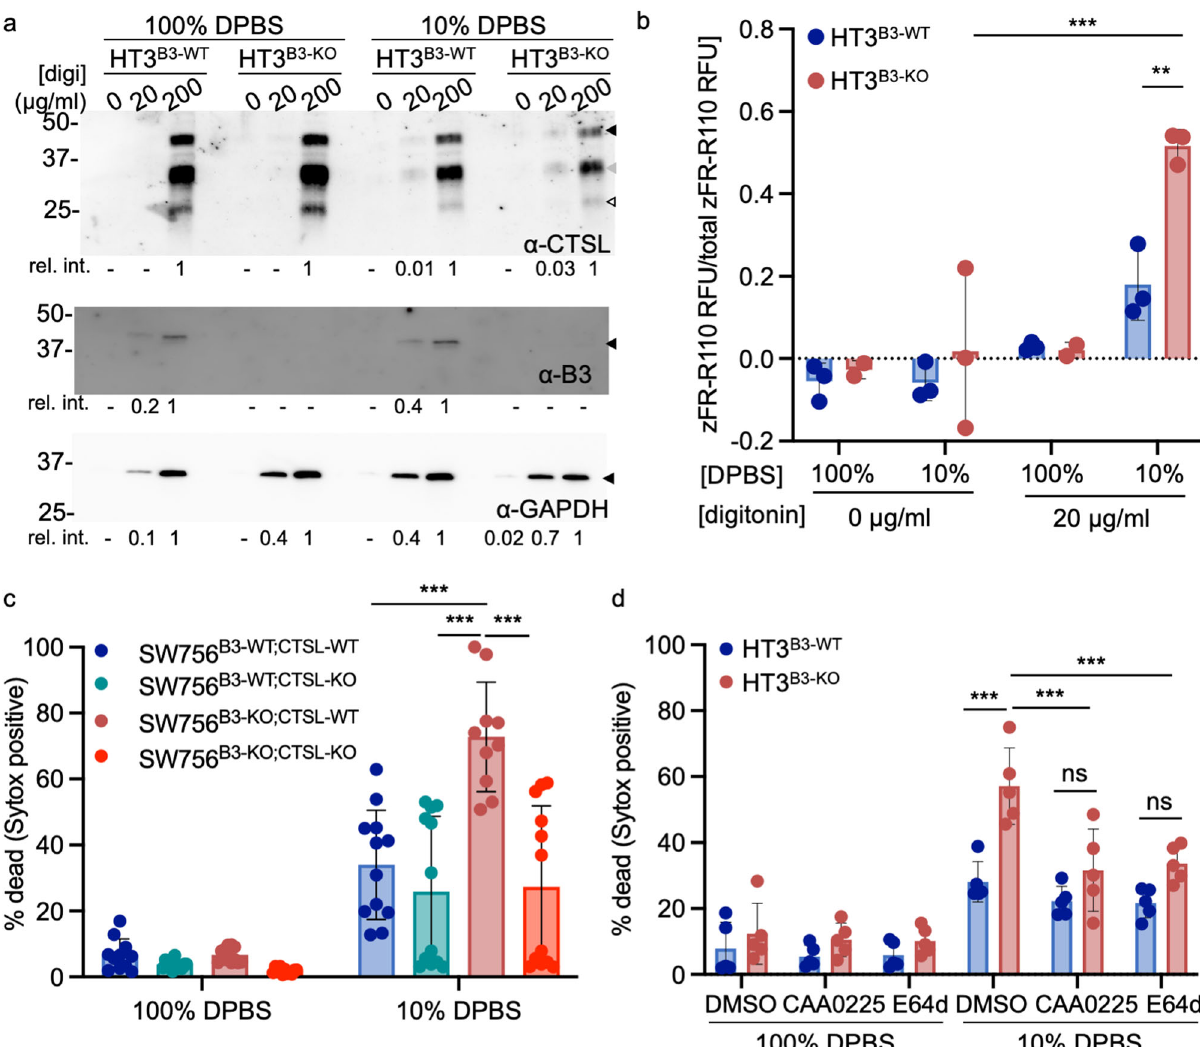
Fig. 5 The lysoptosis-like cell death pathway involves promiscuous cytoplasmic proteolytic activity. a Western blot analysis of lysosomal CTSL (goat polyclonal cathepsin L, Novus, AF952), nucleocytoplasmic SERPINB3 ( α -B3; rabbit polyclonal SERPINB3/B4), and cytosolic GAPDH () in supernatants of HT3 B3-WT and HT3 B3-KO cell lines treated with 100 or 10% DPBS for 30min at 37°C, 5% CO 2 prior to treatment with DPBS containing 0, 20, or 200 µ g/ml digitonin. The relative band intensities (rel. int.) for each lane were calculated (Image Lab, v6.1, Bio-Rad) and are shown under the corresponding lane. Note the detection of CTSL in the 20 µ g/ml digitonin supernatants of both HT3 B3-WT and HT3 B3-KO treated with 10% DPBS but not the 100% DPBS controls. Black arrowheads indicate full-length proteins, gray and open arrowheads demark processed active forms of CTSL. b Pan-lysosomal cysteine protease activity (zFR- R110). Activity in supernatants of HT3 B3-WT and HT3 B3-KO cell lines treated with 100 or 10% DPBS for 30 min at 37°C, 5% CO 2 prior to treatment with DPBS containing 0, 20, or 200 µ g/ml digitonin. The activity was normalized to the 200 µ g/ml control to account for total lysosomal cysteine protease protein levels. Note, the signi fi cantly enhanced cysteine protease activity in HT3 B3-KO cytosolic supernatants (20 µ g/ml digitonin) compared to HT3 B3-WT in 10% DPBS cells treatment. c Bulk CTSL-KO SW756 B3-WT or SW756 B3-KO cell lines were generated by CRISPR/cas9 methodology. The percentage of the bulk population containing indels in the CTSL gene was con fi rmed by NGS sequencing (Table S1) and CTSL protein levels are shown in ref. 114 . Cell lines were then treated with either 100 or 10% DPBS in the presence of SG for 4 h. The % dead was calculated as the number of SG positive cells/the total number of cells as determined by high contrast bright fi eld imaging × 100. Analyses were compared using a two-way ANOVA with Tukeys ’ multiple comparisons ( n ≥ 10 replicates; *** P < 0.001). Note, the statistically signi fi cant reduction in % dead between SW756 B3-KO;CTSL-WT and SW756 B3-KO;CTSL-KO . d HT3 B3-WT or HT3 B3-KO cells were incubated with DMSO, 10 µ M E64d, or 10 µ M cathepsin L selective inhibitor, CAA0225 for 1h prior to exposure to 100 or 10% DPBS for 14h, and stained with SG. Percent dead was calculated as ((Sytox positive nuclei/total cells calculated by bright fi eld microscopy) ×100) ( n = 5 replicates; ns not signi fi cant, *** P < 0.001). Uncropped immunoblots can be found in Supplementary Fig.